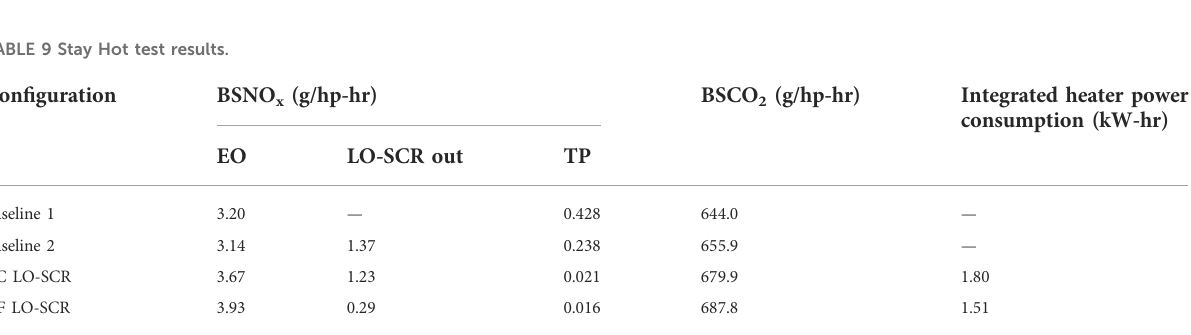
TABLE 9 Stay Hot test